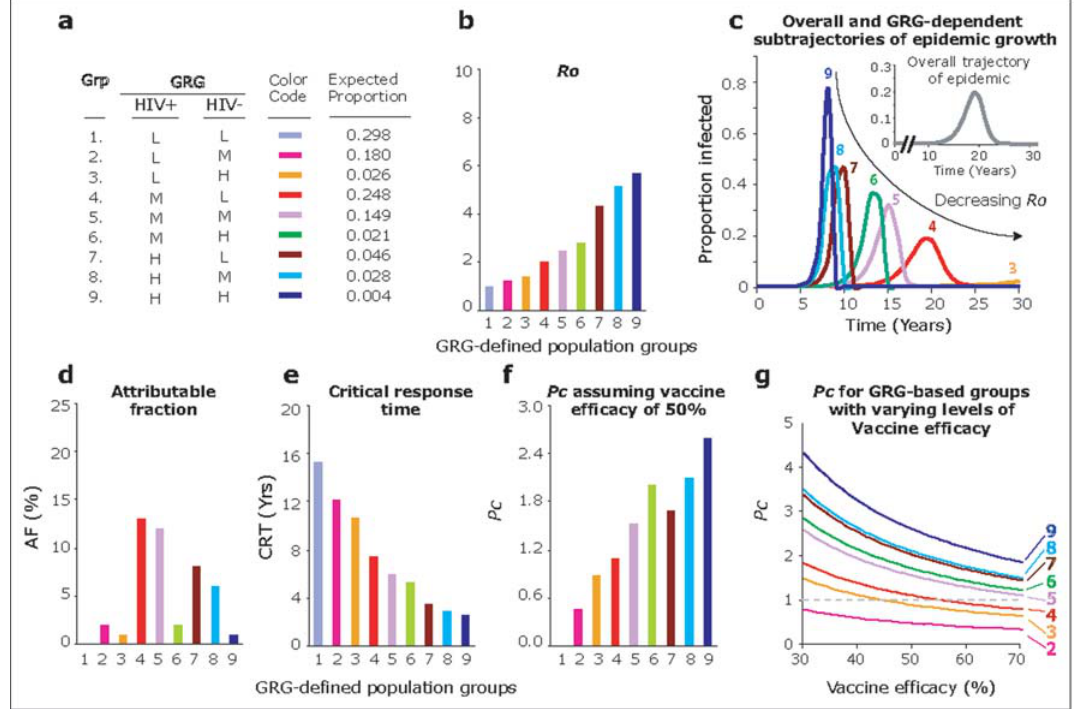
Figure 2. Modeling studies assessing the influence of CCL3L1-CCR5 genotypes on epidemiological parameters relevant to the outgrowth and prevention of HIV-1. ( a ) Nine population groups based on the CCL3L1-CCR5 GRG status of sexual partners. The estimated proportions (prevalence) of the GRGs in the general population are based on data from the HIV-positive WHMC cohort [20]. L, M, and H denote low, moderate, and high GRG status, respectively. The color codes shown are used to illustrate the nine population groups (Grp) in panels b to g. ( b ) Estimates of Ro for the nine color-coded GRG-defined population groups. ( c ) Simulated epidemic growth in GRG-defined population groups. Methods are in SOM , section 1.9 online . ( d to f ) Attributable fractions (AF, panel d), critical response time (CRT, panel e) and Pc (f) in the nine population groups. The calculations for Pc (f) assume a vaccine efficacy of 50%. ( g ) Influence of varying vaccine efficacy estimates on Pc in the nine GRG-defined population. groups shown in panel a. Pc values greater than unity (dashed horizontal line) indicate the point at which repeated mass vaccination might be necessary. Pc for population group # 1 was zero. Additional data relevant to these studies are shown in Table S2 online.